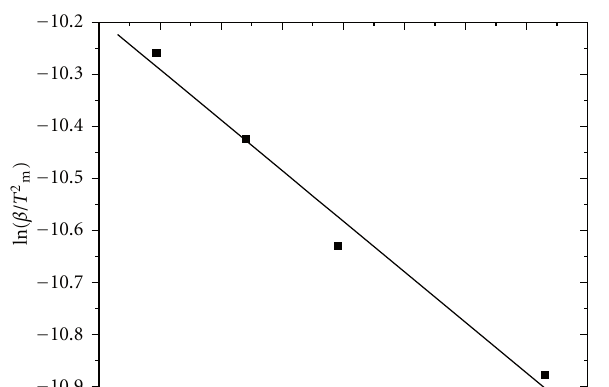
versus 2 𝑚𝑚 𝑑 1000𝑑𝑇𝑇(